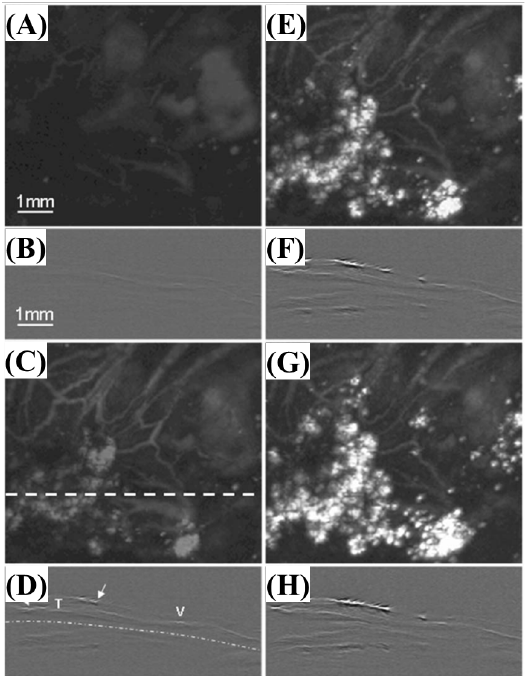
Figure 12. In vivo non-invasive photoacoustic images of nanoshell extravasation from solid tumor vasculature; ( A , C , E , G ) show in vivo maximum-amplitude-projected (MAP) images acquired prior to nanoshell administration; ( B , D , F , H ) show in vivo B-scan images that correspond to the scanning position. Reprinted from Li et al., J. Biomed. Opt., 2009, 14: 010507 [27], with permission from the Optical Society of America.